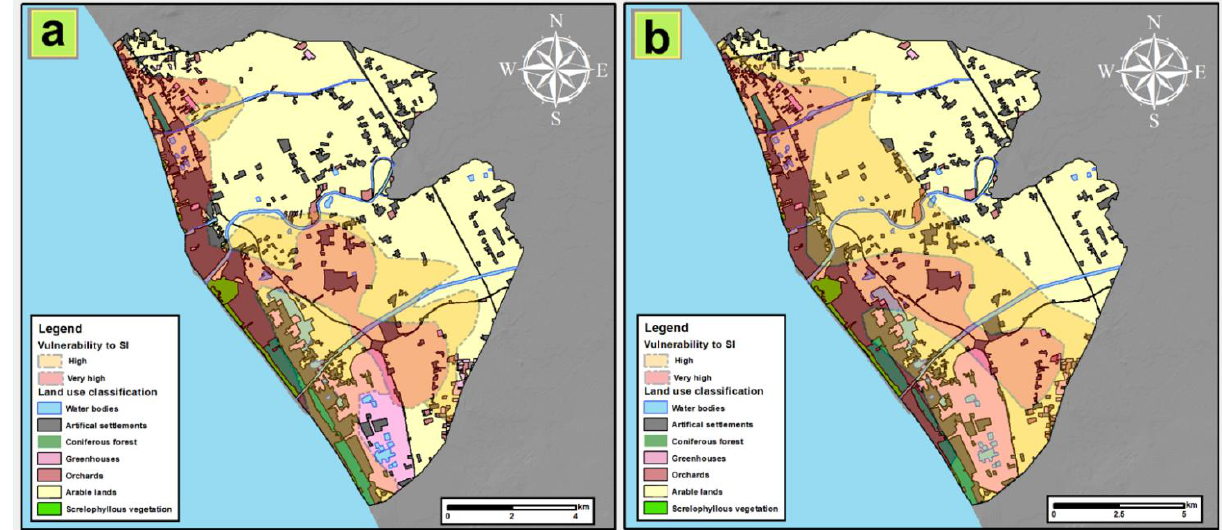
Figure 9. Comparison of actual ( a ) and future ( b ) seawater intrusion (SI) vulnerability with land use classification.